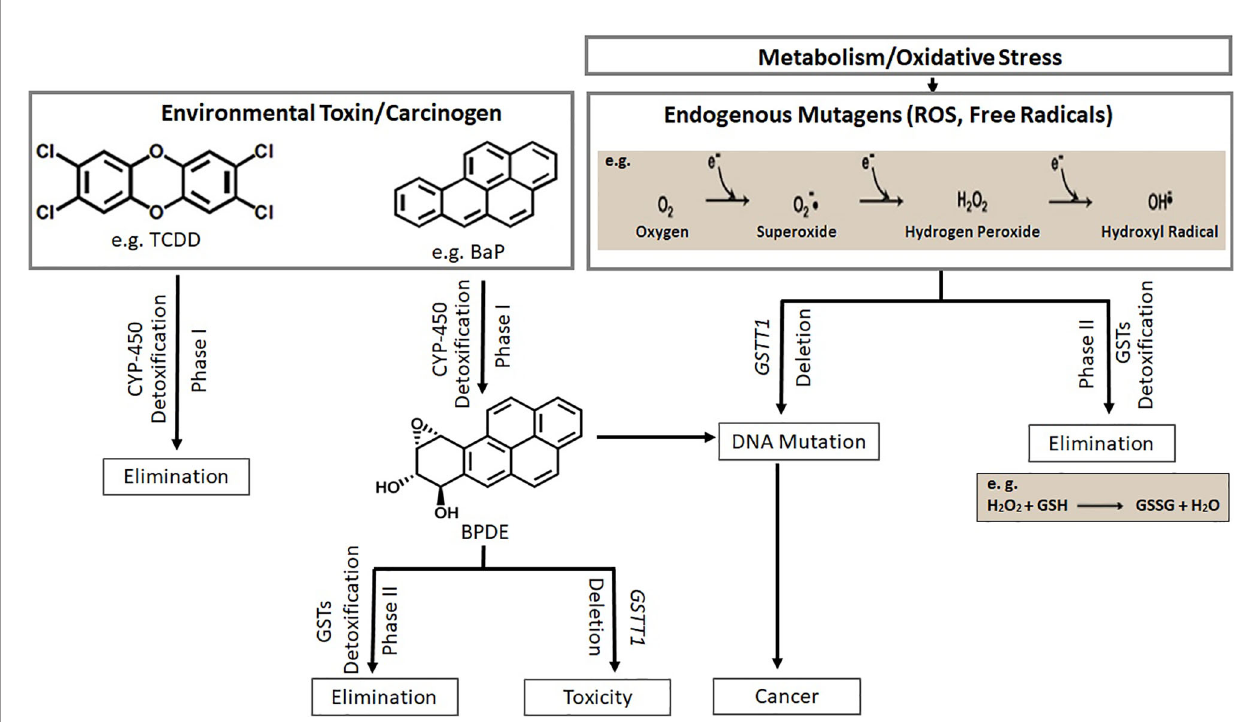
FIGURE 5 | Xeno- and endo-biotic carcinogen metabolism through two pathway systems (phase I and phase II) is shown. Deletion of GSTT1 leads to toxicity and carcinogenesis (TCDD, 2,3,7,8-Tetrachlorodibenzodioxin; BaP, Benzo[a]pyrene; BPDE, Benzo(a)pyrene diolepoxide; ROS, Reactive Oxygen Species).